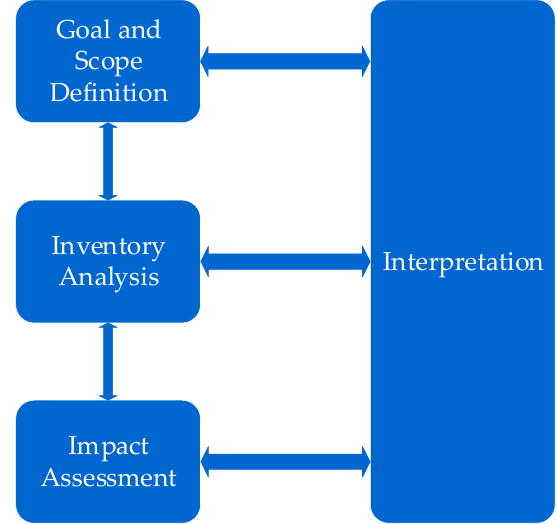
Figure 1. Life cycle assessment framework based on ISO 14044.